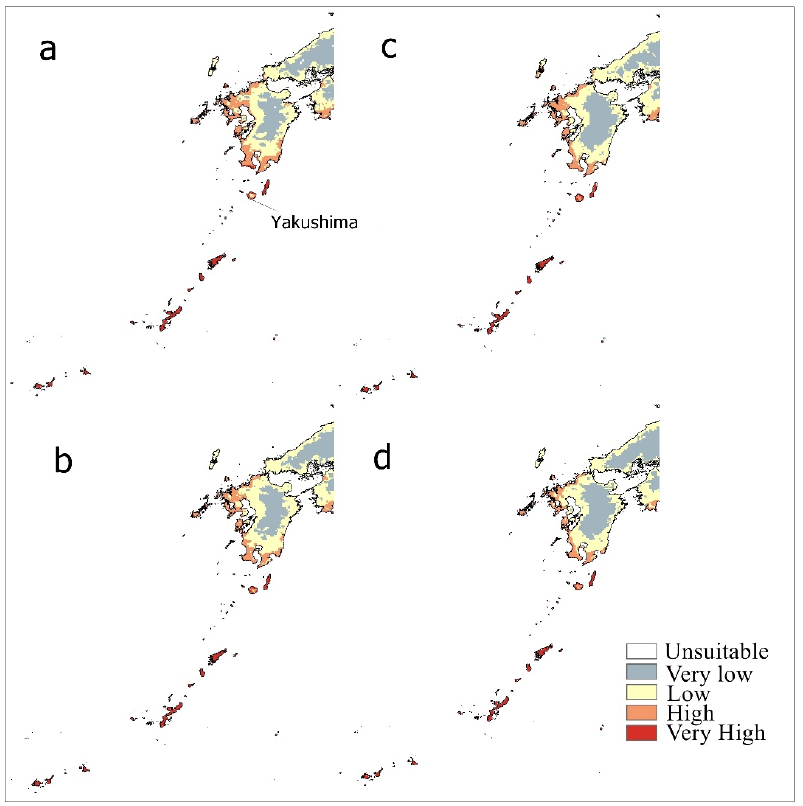
Figure 3. Illustrated zonation of the Southern regions of Japan with a high and very high risk of invasion with OWS in the future: ( a ) RCP 2.6 in 2050, ( b ) RCP 8.5 in 2050, ( c ) RCP 2.6 in 2070, and ( d ) RCP 8.5 in